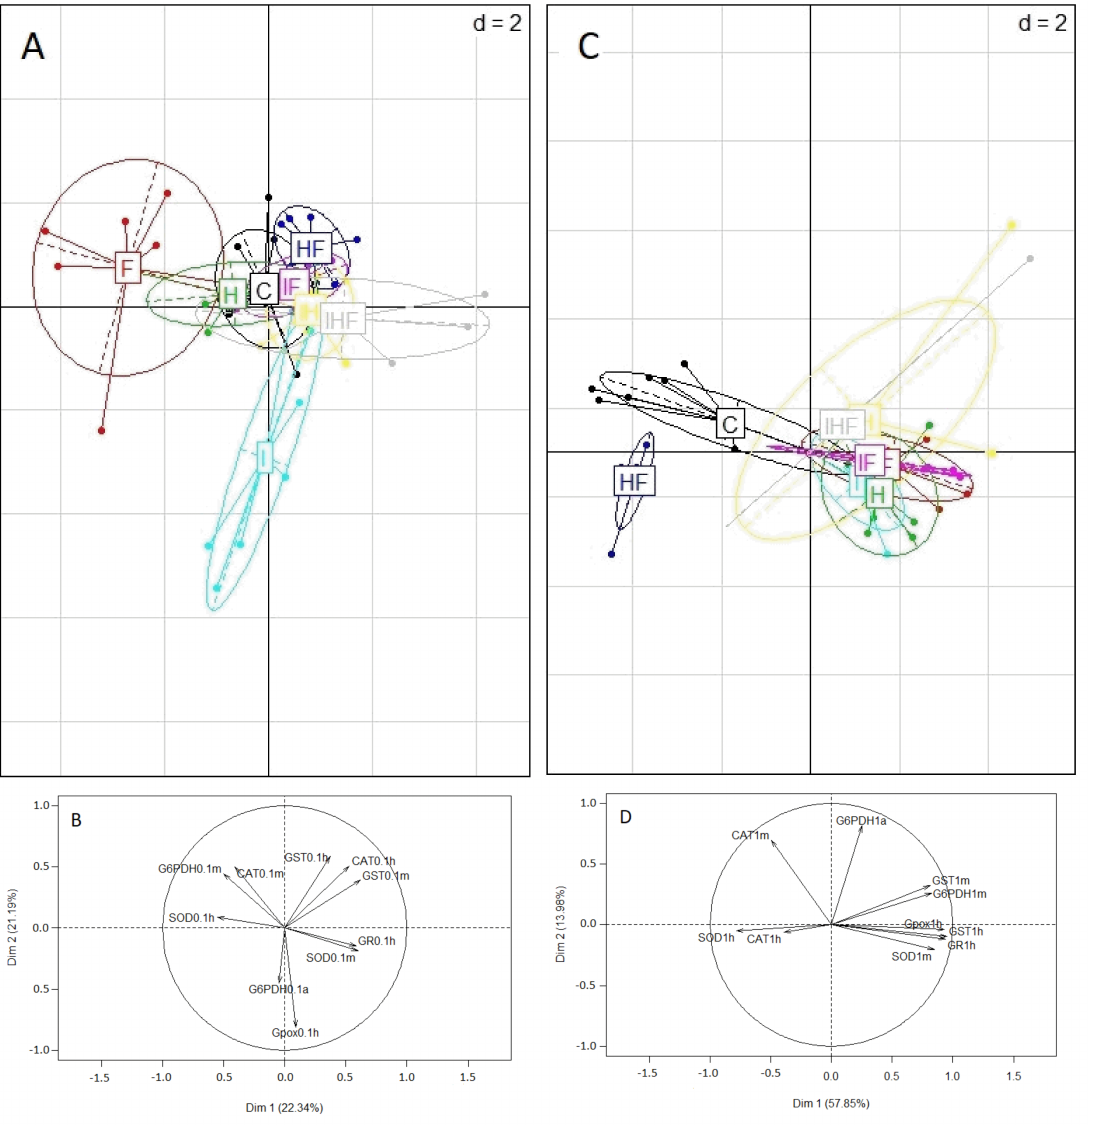
Figure 5. Effects of exposure to pesticides on the physiological state of winter honey bees. Win- ter honey bees were orally exposed to food containing no pesticides (C), imidacloprid (I), difeno- conazole (F), glyphosate (H), imidacloprid + difenoconazole (IF), imidacloprid + glyphosate (IH), glyphosate + difenoconazole (HF), or imidacloprid + glyphosate + difenoconazole (IHF) at concentra- tions of 0.01, 0.1, 1 and 10 µ g/L. On day 16, enzymes involved in antioxidant defenses were assayed. SOD, CAT and GST were measured in the head (h) and midgut (m). GPox and GR were measured in the head (h), and G6PDH was measured in the midgut (m) and abdomen (a). A multiple marker approach was performed to analyze the effects of these pesticides at 0.1 and 1 µ g/L on oxidative stress. Principal component analyses (PCAs) (A and C) provide visual representations of the physiological states of honey bees exposed to the three pesticides individually or in binary and ternary mixtures at 0.1 µ g/L ( A ) and 1 µ g/L ( C ). The correlation circles ( B , D ) indicate the significance of the enzymes in the PCA representations in honey bees exposed to the pesticides individually or in binary and ternary mixtures at 0.1 µ g/L ( B ) and 1 µ g/L ( D ). SOD, superoxide dismutase; CAT, catalase; GST, glutathione- S -transferase; G6PDH, glucose- 6 -phosphate dehydrogenase; GR, glutathione reductase; GPox, glutathione